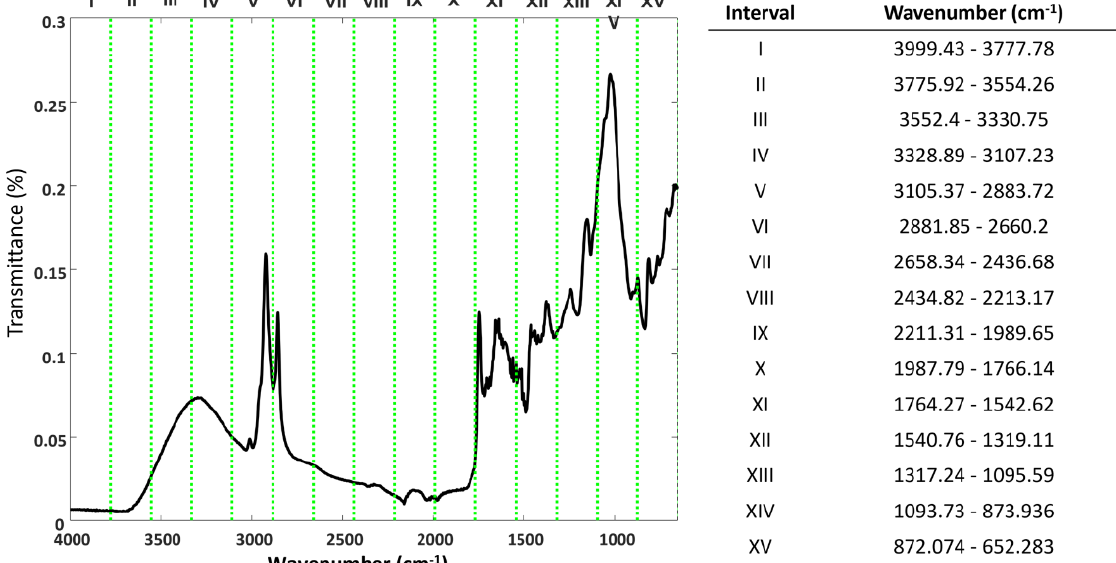
Figure 3. Infrared spectrum obtained from coffee samples roasted in different roasting profiles (baked, light, medium, and dark) using two roasters (Probatino and Golden Plus). This spectrum was divided into 15 intervals (I to XV) for application of the Interval Principal Component Analysis (iPCA) technique.